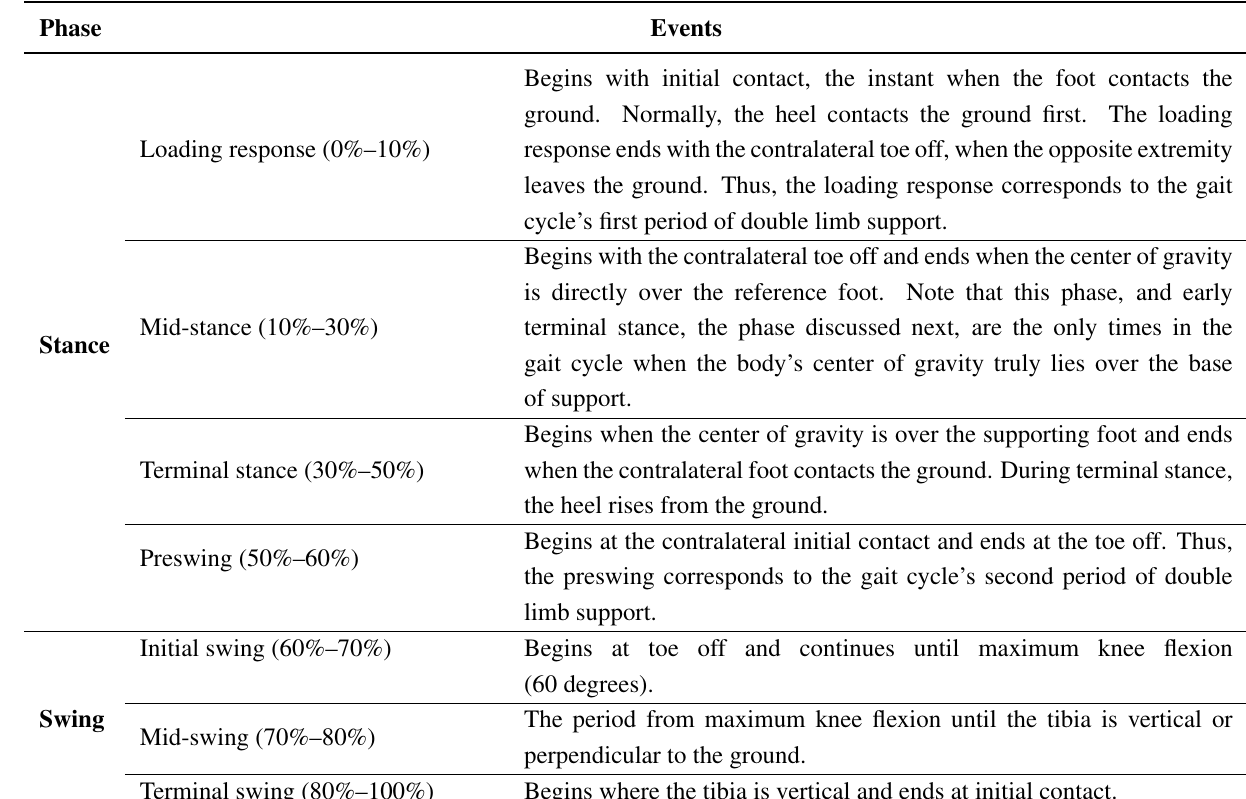
Table 1. Subdivisions of the stance and swing phases of the gait